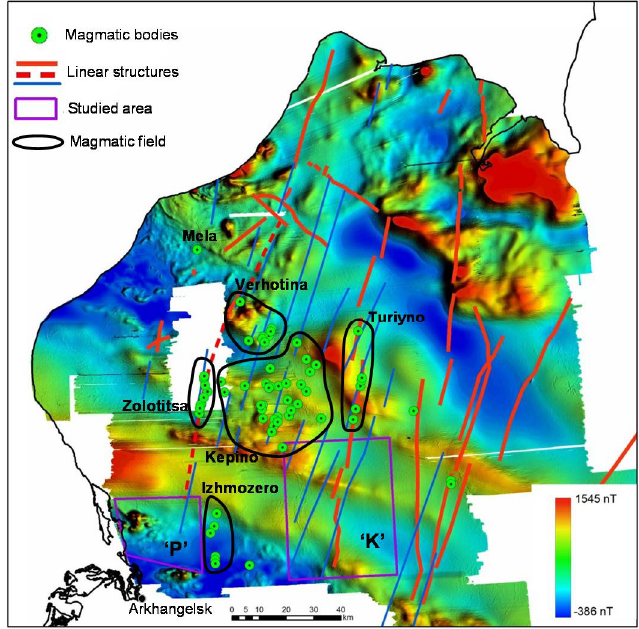
Figure 2. Map of anomalous magnetic field ∆ T for the Arkhangelsk Diamondiferous Province (ADP). Magmatic field from [11].